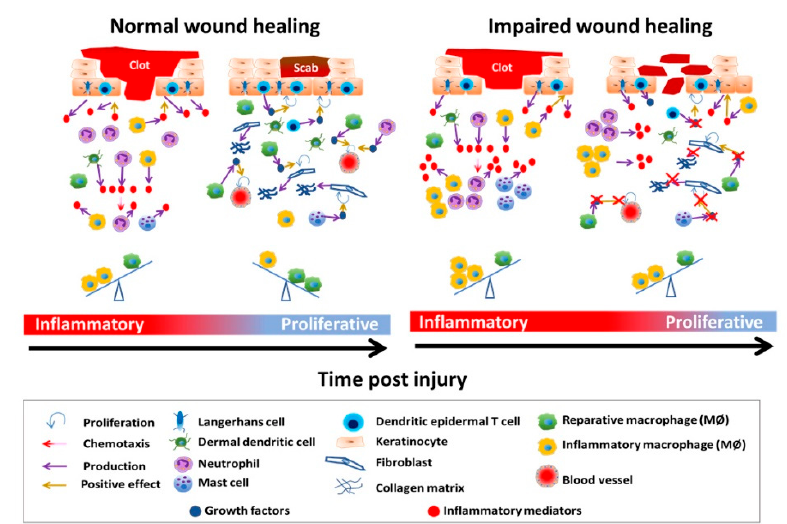
Figure 1. Schematic of normal and impaired wound healing. The inflammatory phase is hallmarked by infiltration of the wound by activated immune cells. Chemotaxis of immune cells to the injury site is facilitated by the presence of inflammatory mediators, which can be produced by skin-resident cells such as keratinocytes, dermal dendritic cells, Langerhans cells, and macrophages. The proliferative phase is characterized by expansion of keratinocytes and endothelial cells to restore the barrier function of the skin and vasculature of the tissue, respectively. Fibroblasts are major producers of collagen fibers in the wound bed and a source of de novo synthesized extracellular matrix. Efficient wound healing is characterized by the timely transition from the inflammatory to the proliferative phase. For this to occur, several events have to happen in concert: neutrophil numbers in the wound decrease, macrophages shift in phenotype from inflammatory to reparative, collagen deposition, and revascularization, thus facilitating wound closure. Chronic wounds are characterized by high levels of inflammation, and decreased production of growth factors, decreased proliferation of endothelial cells, and lack of re-epithelialization. For simplicity, the remodeling phase, certain immune cell types such as tissue-resident T lymphocytes, and nerve fibers are omitted. Wound complications such as bacterial infections and scarring are also omitted.